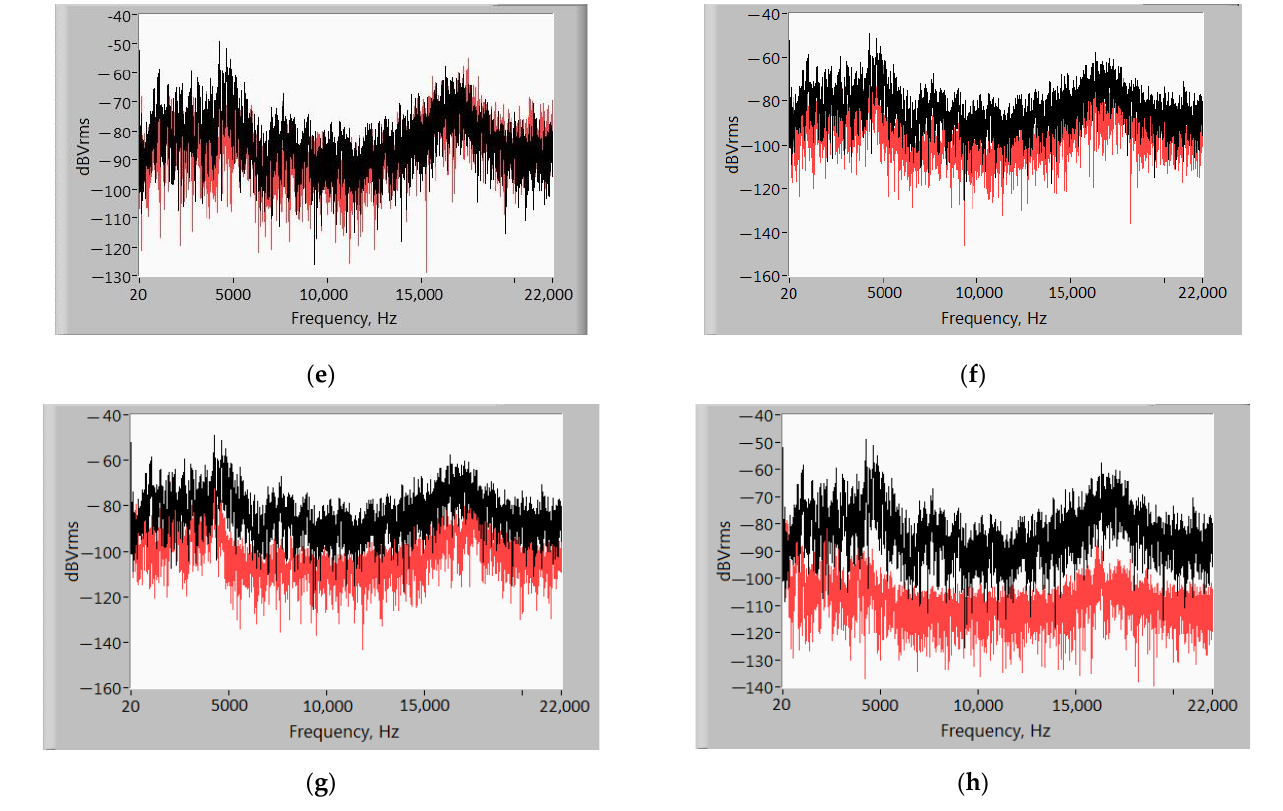
Figure 13. Spectra of acoustic signals of the pipeline at a pressure of 2 bar (the spectrum of a defect– free pipeline is indicated in black; the spectrum of a pipeline with a leak is indicated in red): ( a ) for a defect diameter of 1 mm, ( b ) for a defect diameter of 2 mm, ( c ) for a defect diameter of 3 mm, ( d ) for a defect diameter of 4 mm, ( e ) for a defect diameter of 5 mm, ( f ) for a defect diameter of 6 mm, ( g ) for a defect diameter of 7 mm, ( h ) for a defect diameter of 8 mm.